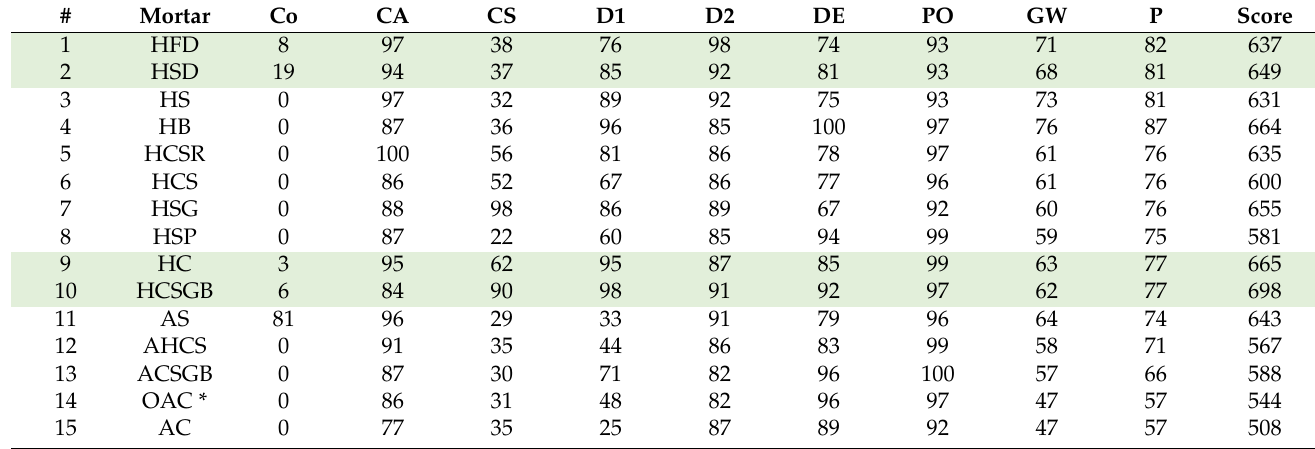
Table 10. Assignment of values for restoration mortars for Lutetian